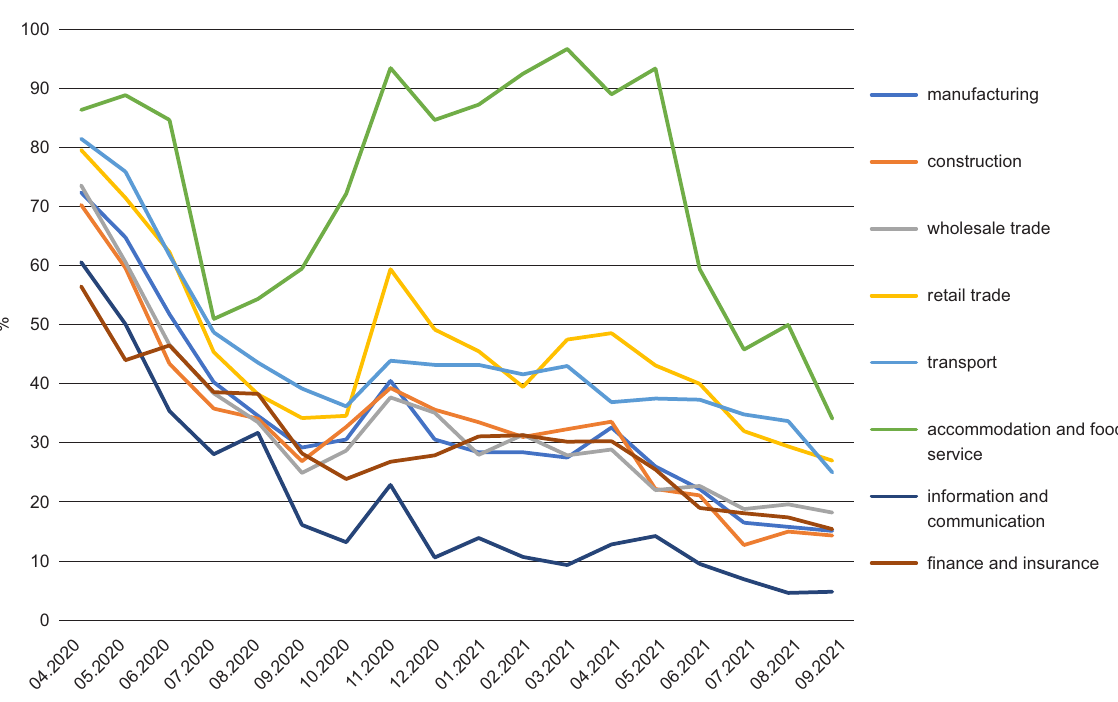
Fig. 6. Proportion of Polish industrial, construction and service enterprises assessing the impact of the COVID-19 pandemic as serious or threatening the stability of the company during the pandemic in Poland, Source: own study based on GUS data from the publication: The impact of the COVID-19 pandemic on the economic situa - tion – assessments and expectations (detailed data and time series) – Annexe to the publication: “Economic situation in manufac - turing, construction, trade and services 2000–2021 (September 2021)” (GUS, 2021)